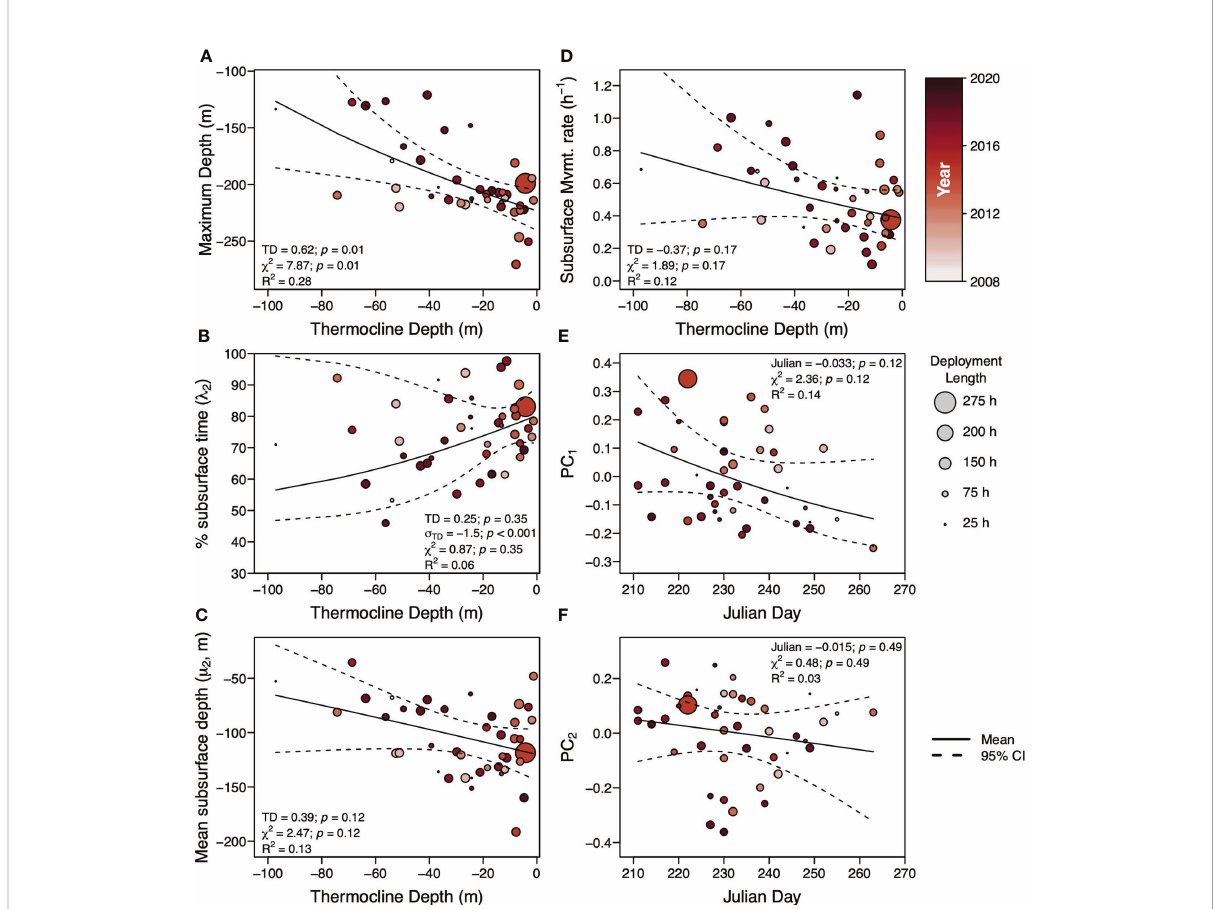
FIGURE 6 Summary of basking shark vertical movement metrics as a function of the top covariate in the most parsimonious linear model. For maximum depth over the deployment (A) , percent bottom time ( l 2 ) (B) , depth mean of the second mixture ( m 2 ) (C) , and subsurface movement rate (D) , the top covariate was thermocline depth while for the fi rst principal component from the PCA of the proportion of subsurface movements in each shape cluster (E) and the second principal component from the PCA of the proportion of subsurface movements in each shape cluster (F) , the top covariate was Julian Day. Circles indicate the metric for each individual shark and its radius indicates the length of individual deployment used to weight deployments in the linear models. The color of the circle indicates the year of the deployment (darker colors indicate more recent years). The solid black line indicates the mean and the dashed black line indicates the 95% con fi dence interval of the linear model predictions. Con fi dence intervals may be asymmetric due to normalization of the movement metrics. For each metric, the slope (TD for thermocline depth or Julian for Julian day) and its p -value, the slope of the dispersion parameter ( s TD for thermocline depth or s Julian for Julian day) and its p -value (if included in the most parsimonious model), the c 2 statistic and its p -value, and the R 2 are